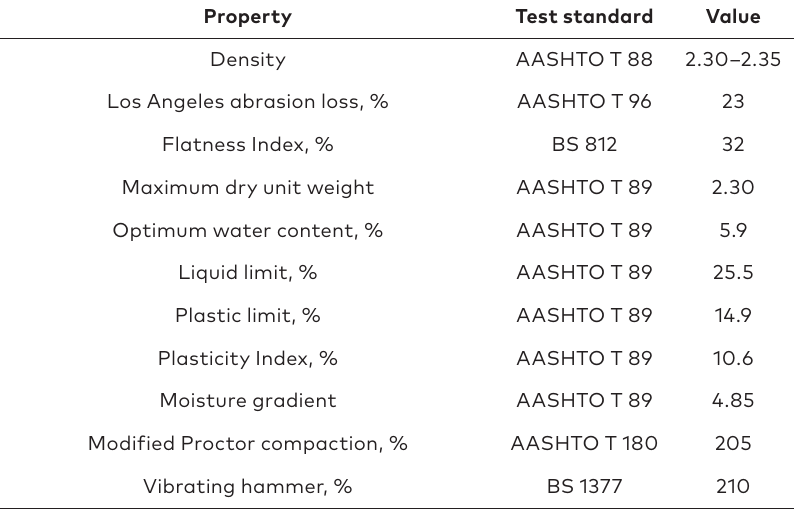
Table 7. Physical and mechanical properties of granular base